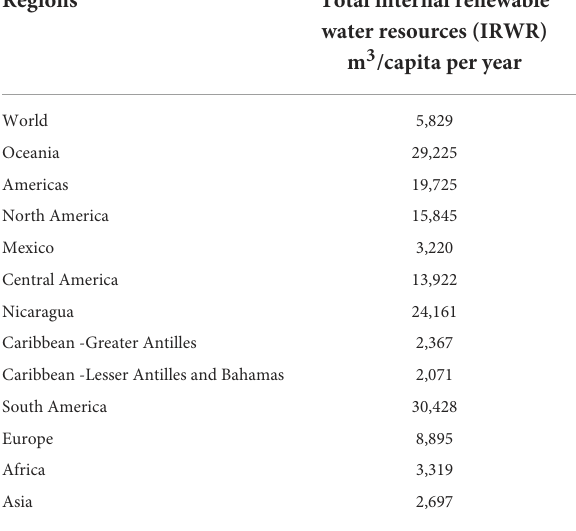
TABLE 1 Total internal renewable water resources (m 3 /capita per year) [Food Agriculture Organization of the United Nations (FAO-AQUASTAT),